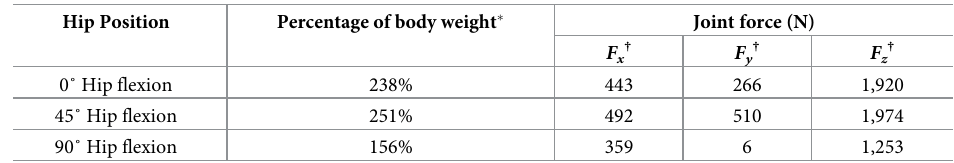
Table 2. Loading conditions §